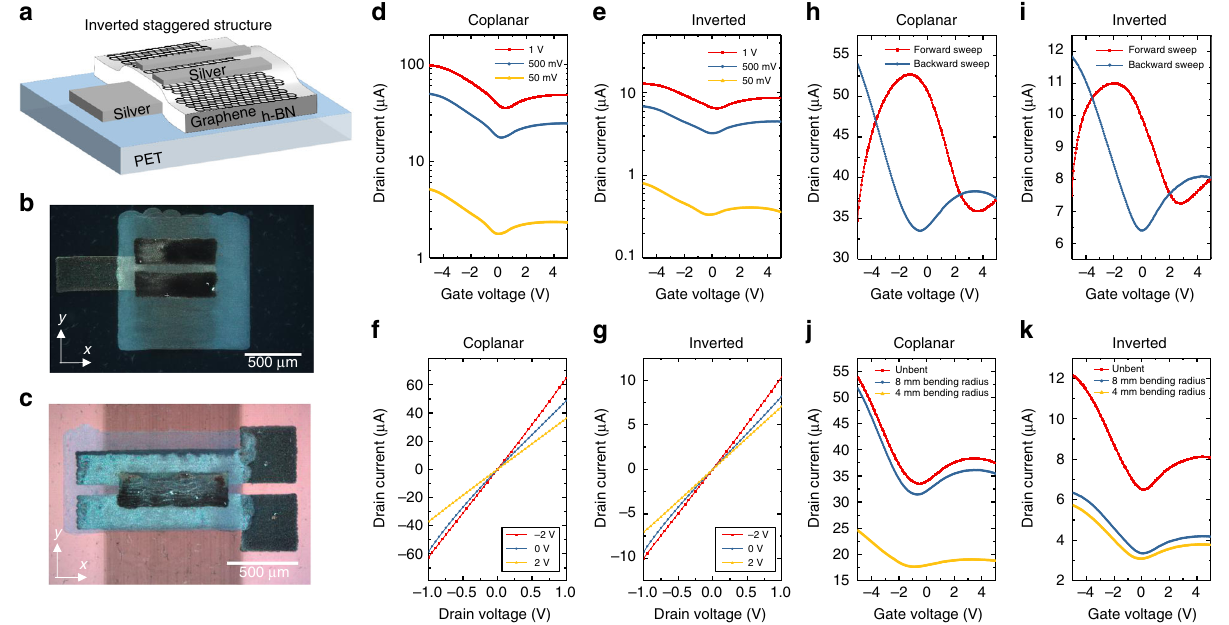
Fig. 3 Inkjet-printed inverted-staggered FET on PET. a Schematic of a printed inverted-staggered FET heterostructure. Optical microscopy images (dark fi eld) of the b inverted-staggered and c coplanar FET heterostructures on PET with channel lengths of 50 and 65 μ m, respectively. d , e Transfer characteristics and f , g linear output characteristics of the FETs as a function of V ds . h , i Transfer characteristics of the FETs with observable hysteresis depending on sweep direction at V ds = 1 V. j , k Transfer characteristics of the FETs as a function of bending radius in the x -direction at V ds = 1